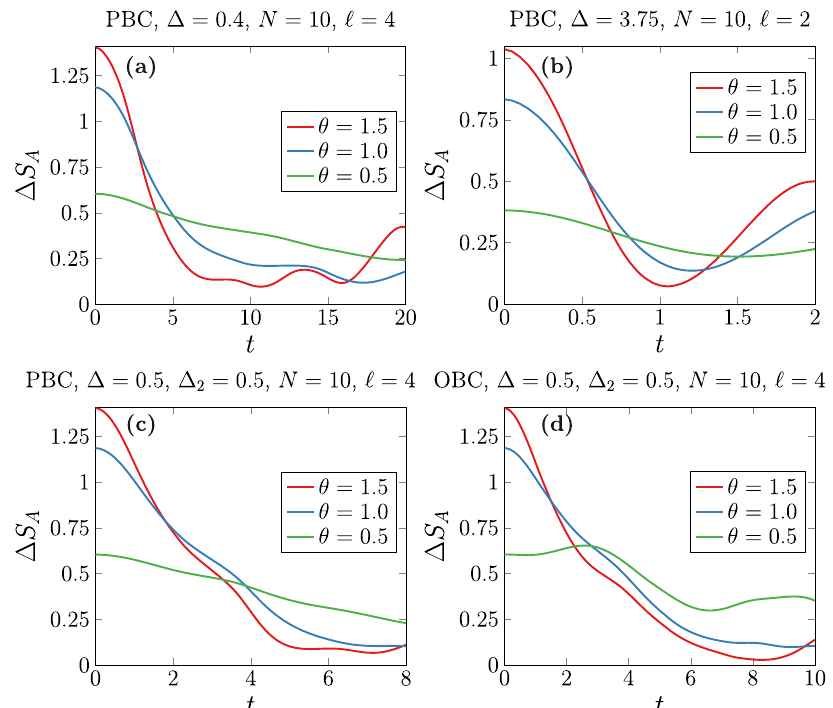
Fig. 4 | Quantum Mpemba effect in interacting integrable and non-integrable spin chains. We plot the time evolution of the entanglement asymmetry Δ S A ( t ) afterpreparingthespinchainat t =0inthetiltedferromagneticstateofEq.(6)and performingasuddenquenchtotheHamiltonian H giveninEq.(15)withtotallength N =10. The continuous lines have been obtained via exact diagonalization for dif- ferentchoicesofthesubsystemlength ℓ ,initialtiltingangle θ ,andofthecouplings